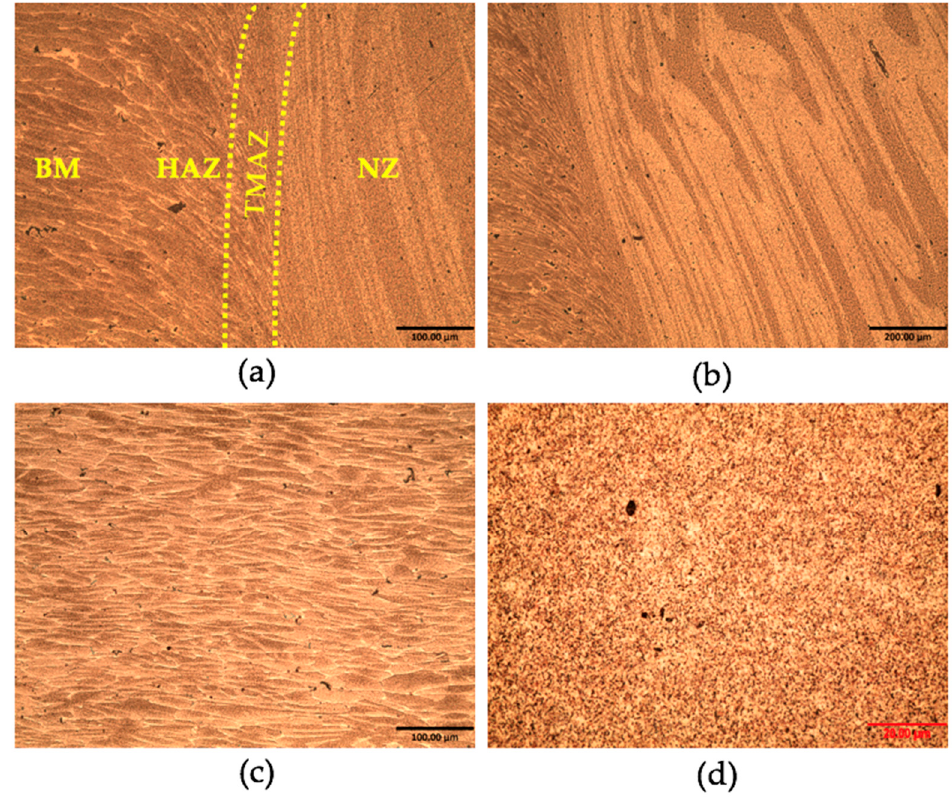
Figure 1. Optical micrographs of 7075 aluminum alloy after FSW showing ( a ) different zones formed after FSW; ( b ) weld area; ( c ) pancake-shaped grains in BM and ( d ) ultra-fine grains in the NZ.